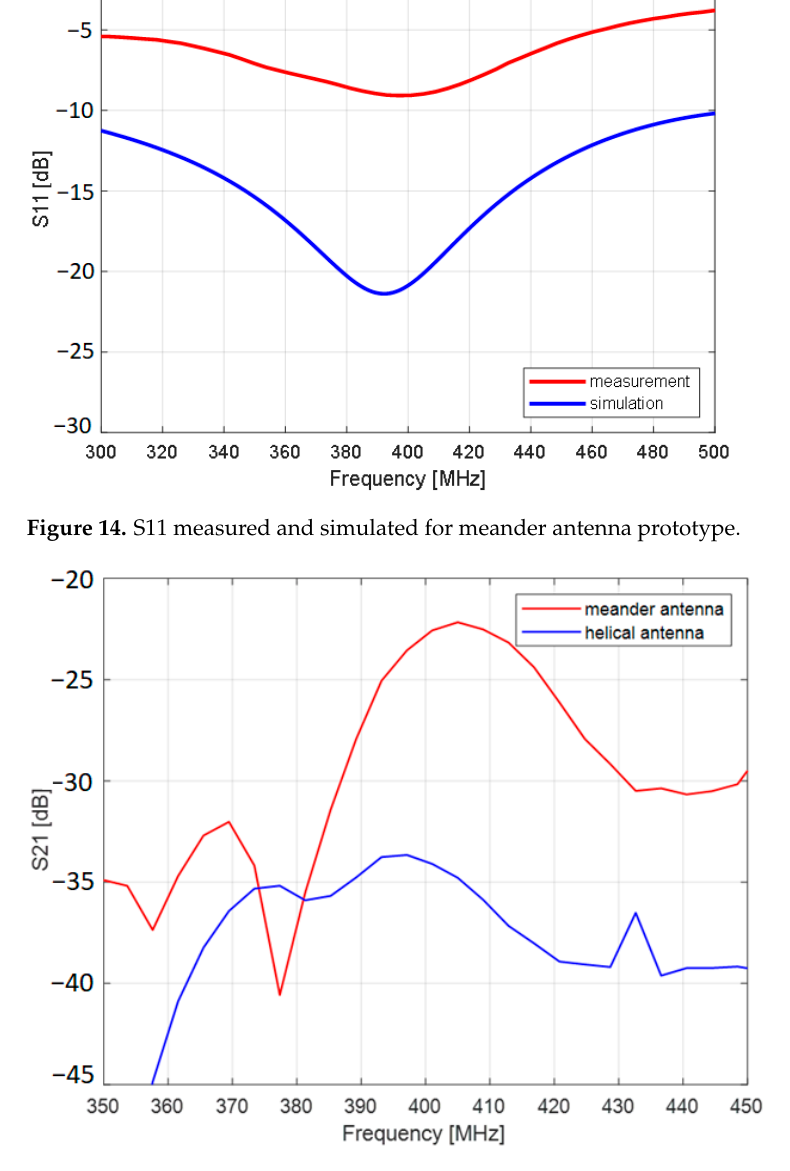
Figure 15. S21 measured for meander antenna prototype and helical antenna prototype.